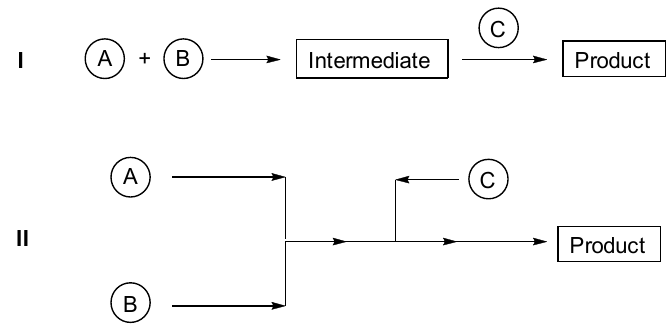
Figure 1. Schematic drawings of a batch and a continuous flow system.